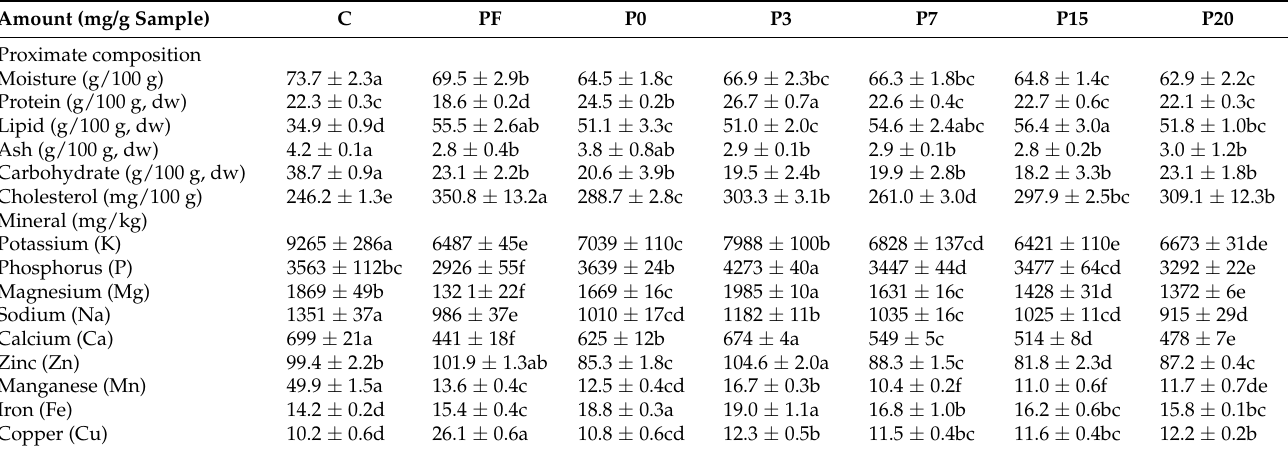
Values are given as mean ± standard deviation from triplicate determinations. Different letters in the same row indicate significant differences ( p < 0.05). dw = dry weight. Diet nomenclature: C: control, PF: diet